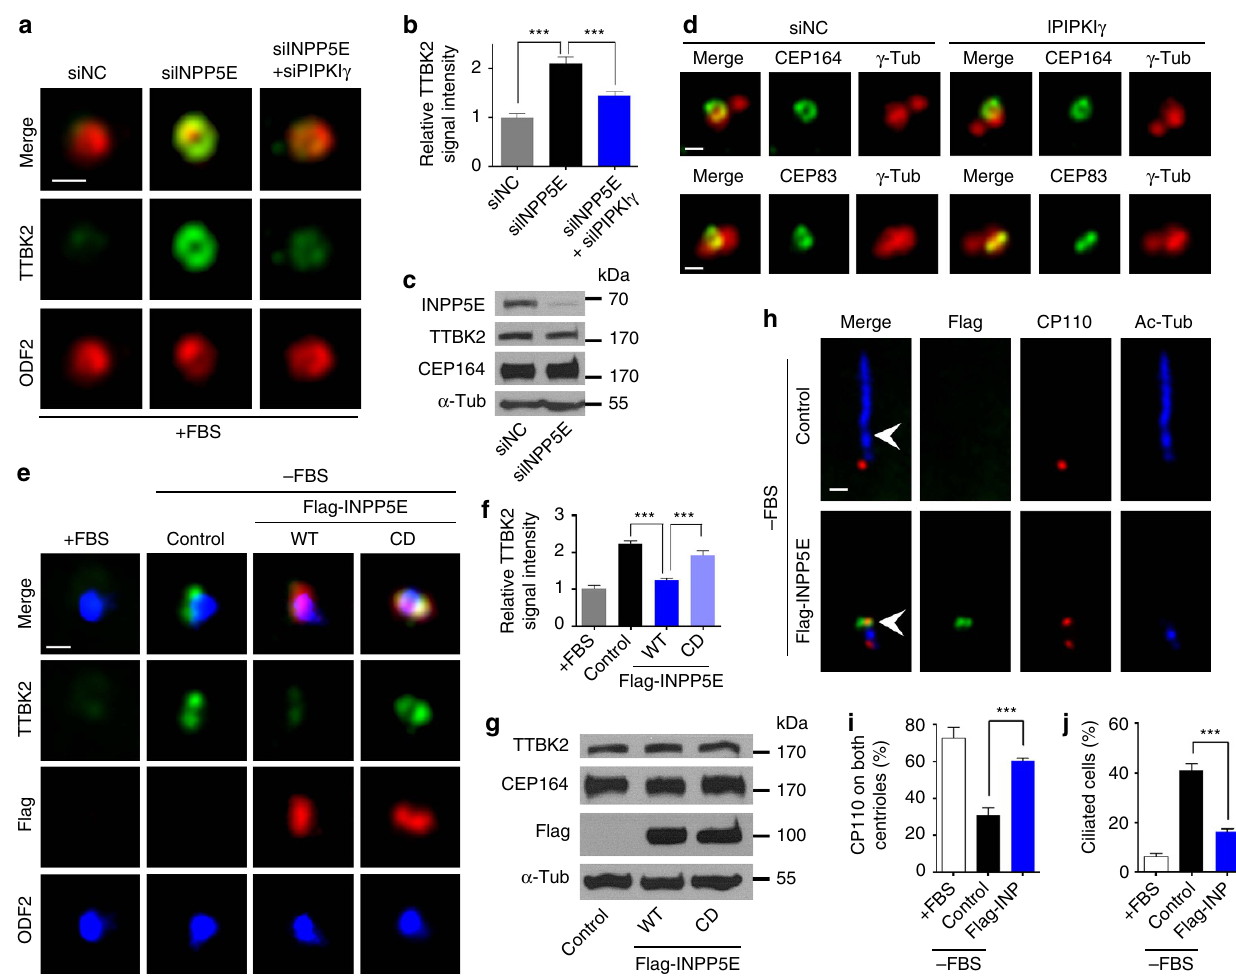
Figure 4 | INPP5E inhibits the association of TTBK2 with the M-centriole/basal body. ( a , b ) TTBK2 was visualized by IF microscopy in serum-fed RCTE cells 72h post transfection of the negative control (siNC), INPP5E-specific (siINPP5E) and/or PIPKI g -specific (siPIPKI g ) siRNAs. ODF2 was used as a centrosome marker. ( b ) The centrosomal TTBK2 intensity in cells ( n 4 30) of each group was quantified and plotted from three independent experiments. ( c , d ) RCTE cells treated with siNC or siINPP5E were collected for immunoblotting ( c ) or IF microscopy ( d ) with indicated antibodies. a -Tub, a -tubulin. ( e , f ) RCTE cells were transfected with empty vector (Control), wild type (WT) or catalytic defective (CD) Flag-INPP5E for 8h, and serum starved for additional 8h before stained with indicated antibodies. In each group, the intensity of centrosomal TTBK2 signal in 4 30 cells was quantified from at least three independent experiments and plotted. Error bars represent s.e.m. ( g ) Cells transfected with empty vector (Control), WT or CD Flag-INPP5E were collected for immunoblotting with indicated antibodies. ( h – j ) RCTE cells transfected with empty vector (Control) or wild-type Flag-INPP5E for 24h were serum-starved for additional 36h, and then stained with appropriate antibodies. Percentage of cells with CP110 on both centrioles ( i ; n 4 100) or with primary cilium ( j ; n 4 200) was quantified in each group. Results from at least three independent experiments were plotted. Error bars represent s.d. *** P o 0.001. Scale bars, 0.5 m